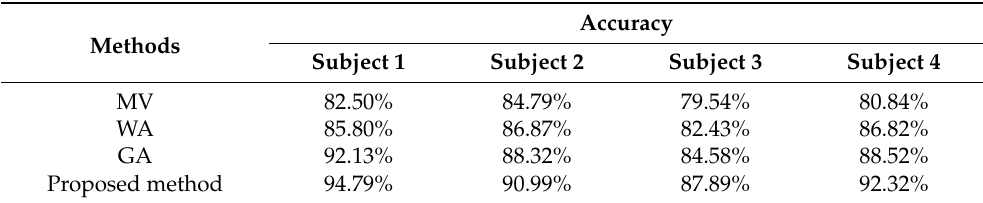
Table 3. The performance comparison of different fusion strategies for 4 subjects in OPPORTU- NITY dataset.